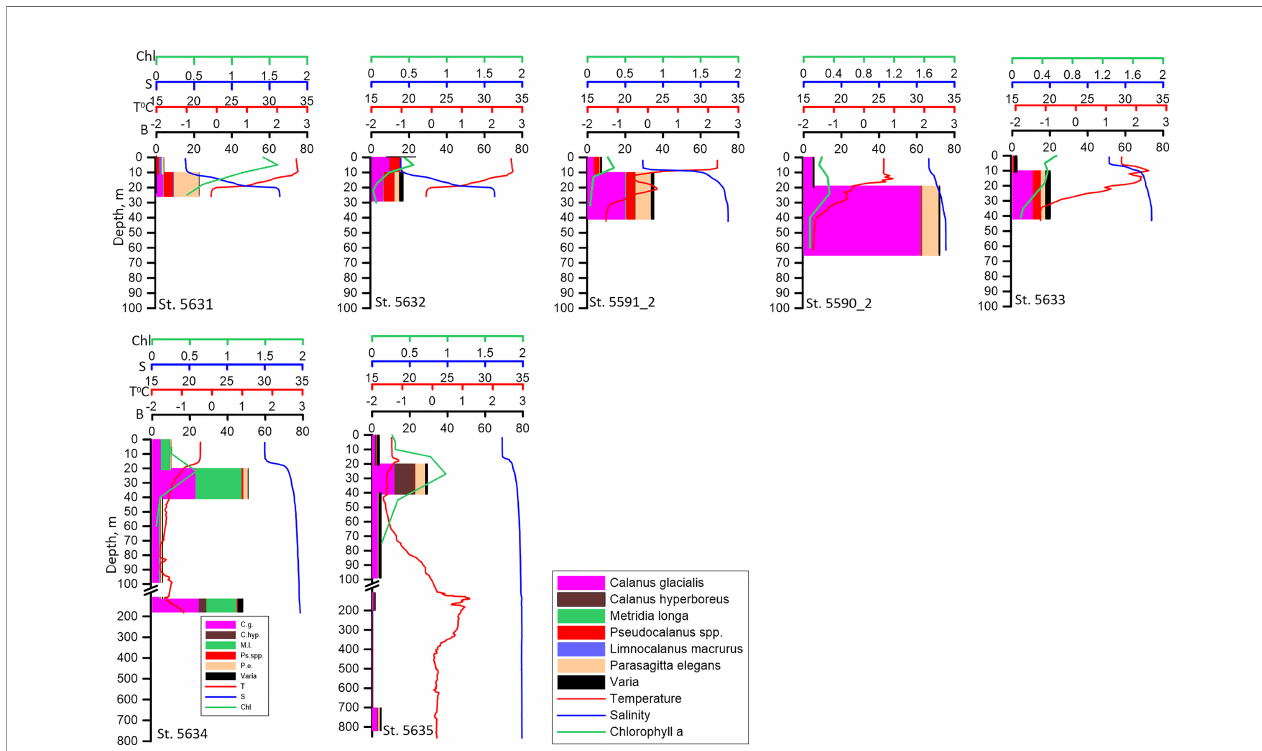
FIGURE 5 | Vertical distribution of biomass of the dominant species (B, mg DW m -3 ), temperature (T° C), salinity (S) and Chlorophyll a (Chl, mg m -3 ) along the Khatanga transect. Note that the bulk of the biomass occupies the layer below the